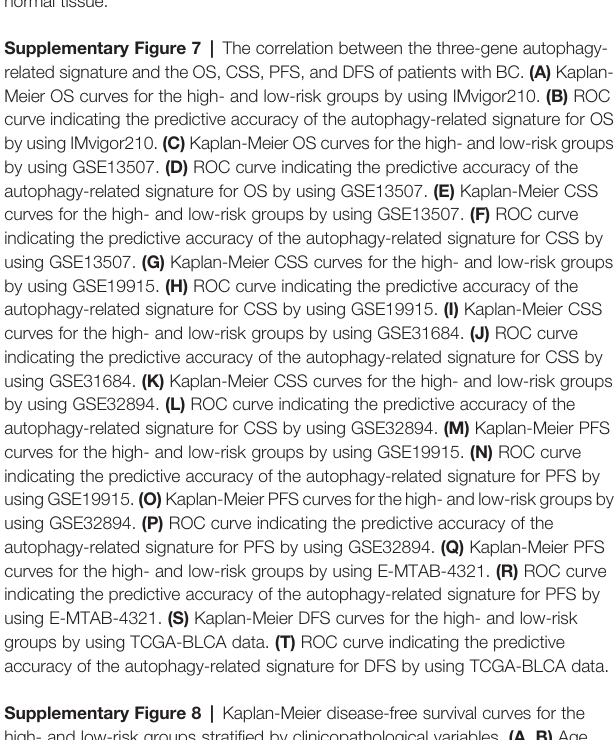
Supplementary Figure 1 | The fl ow diagram of this study. Data preparation, analysis, and validation are shown in the fl ow diagram. Supplementary Figure 2 | (A) Sample clustering to detect outliers. (B) Sample dendrogramandtraitheatmap.Thecolorintensitywasproportionaltodiseasestatus. Supplementary Figure 3 | Determination of soft-thresholding power in the weighted gene co-expression network analysis (WGCNA). (A) Analysis of the scale- free fi t index for various soft-thresholding powers ( b ). (B) Analysis of the mean connectivity for various soft-thresholding powers. (C) Histogram of connectivity distribution when b = 4. (D) Checking the scale free topology when b = 4. Supplementary Figure 4 | Identi fi cation of potential prognostic biomarkers. (A) Identi fi cation ofoverlapped ARGsbetween hubgenesfrom WGCNA andDEGs. (B) GO biological processes analysis. (C) KEGG pathway enrichment. Supplementary Figure 5 | Kaplan – Meier disease free survival (DFS) curves for BLCA patients assigned to groups of high and low expression level of based on the nine genes, respectively. (A – I show the results of ABL1, BOC, EIF4EBP1, FGF7, KCNK3, MAP1A, MYLK, PPARGC1A, REEP2, respectively). Supplementary Figure 6 | Visualization of the expression levels of the 9 differentially expressed autophagy-related genes based on TCGA-BLCA data (A) and GSE13507 (B) . Red represents bladder cancer tissue, and blue represents normal tissue. Supplementary Figure 7 | The correlation between the three-gene autophagy- related signature and the OS, CSS, PFS, and DFS of patients with BC. (A) Kaplan- Meier OS curves for the high- and low-risk groups by using IMvigor210. (B) ROC curve indicating the predictive accuracy of the autophagy-related signature for OS by using IMvigor210. (C) Kaplan-Meier OS curves for the high- and low-risk groups by using GSE13507. (D) ROC curve indicating the predictive accuracy of the autophagy-related signature for OS by using GSE13507. (E) Kaplan-Meier CSS curves for the high- and low-risk groups by using GSE13507. (F) ROC curve indicating the predictive accuracy of the autophagy-related signature for CSS by using GSE13507. (G) Kaplan-Meier CSS curves for the high- and low-risk groups by using GSE19915. (H) ROC curve indicating the predictive accuracy of the autophagy-related signature for CSS by using GSE19915. (I) Kaplan-Meier CSS curves for the high- and low-risk groups by using GSE31684. (J) ROC curve indicating the predictive accuracy of the autophagy-related signature for CSS by using GSE31684. (K) Kaplan-Meier CSS curves for the high- and low-risk groups by using GSE32894. (L) ROC curve indicating the predictive accuracy of the autophagy-related signature for CSS by using GSE32894. (M) Kaplan-Meier PFS curves for the high- and low-risk groups by using GSE19915. (N) ROC curve indicating the predictive accuracy of the autophagy-related signature for PFS by usingGSE19915. (O) Kaplan-MeierPFScurvesforthehigh-andlow-riskgroupsby using GSE32894. (P) ROC curve indicating the predictive accuracy of the autophagy-related signature for PFS by using GSE32894. (Q) Kaplan-Meier PFS curves for the high- and low-risk groups by using E-MTAB-4321. (R) ROC curve indicating the predictive accuracy of the autophagy-related signature for PFS by using E-MTAB-4321. (S) Kaplan-Meier DFS curves for the high- and low-risk groups by using TCGA-BLCA data. (T) ROC curve indicating the predictive accuracy of the autophagy-related signature for DFS by using TCGA-BLCA data. Supplementary Figure 8 | Kaplan-Meier disease-free survival curves for the high- and low-risk groups strati fi ed by clinicopathological variables. (A, B) Age. (C, D) Gender. (E, F) Grade. (G, H) Stage. Supplementary Figure 9 | The prognostication value of the ARG-based signature to disease stage and tumor grade by ROC curves. ROC curves to distinguish BCs of Ta-T1 stage from BCs of T2-T4 stage by using E-MTAB-4321 (A) ,GSE13507 (B) , GSE19915 (C) ,GSE32894 (D) . ROCcurvesto distinguishBCs of Ta-T1 stage from BCs of T2-T4 stage by using TCGA-BLCA data (E) . ROC curves to distinguish BCs of high grade from BCs of low grade by using E-MTAB- 4321 (F) ,GSE13507 (G) ,GSE19915 (H) ,GSE32894 (I) , andTCGA-BLCAdata (J) . Supplementary Figure 10 | The nomogram without the ARG signature for predicting the proportion of patients with 1-, 3- or 5-year